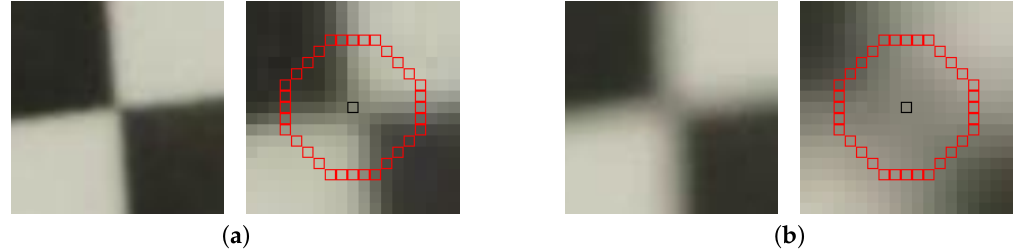
Figure 2. Illustration of the effect of focal blur on the corners. ( a ) in-focus corner, with the six-radius circular boundary highlighted on a detailed version; ( b ) badly out-of-focus corner with the similar enlarged